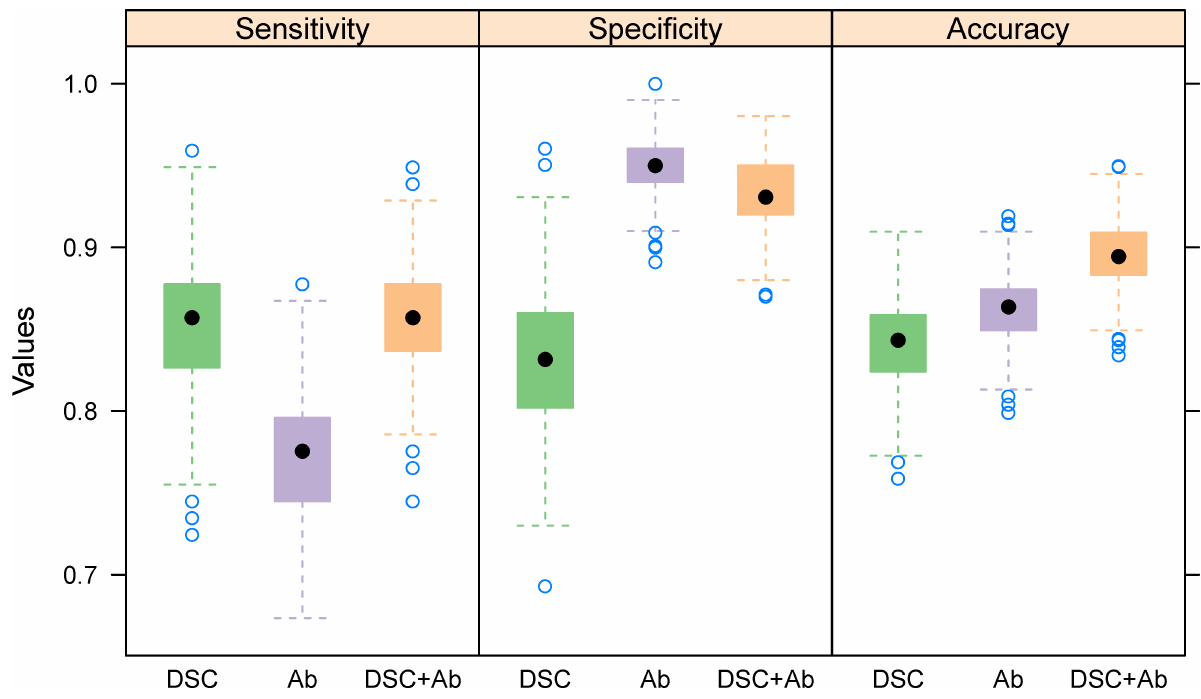
Fig 4. Sensitivity, specificity, and overall accuracyfor classifying lupus patients vs. controls based on DSC thermograms only (DSC), antibody tests only (Ab), and combined DSC / antibody tests (DSC+Ab). Boxplots represent values from 1000 test data sets created by splitting the data randomly into training(two thirds) and testing (one third)